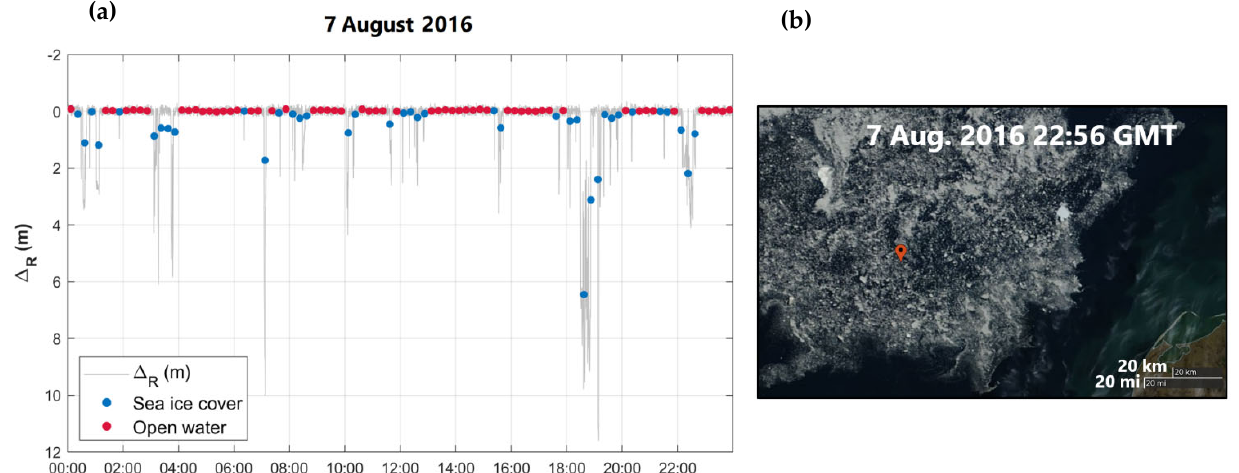
Figure 10. Plot of ∆ R with the SOM analysis for 7 August 2016 with accompanying mostly cloud-free true color Terra/MODIS satellite image. The full-resolution ∆ R time series (( a ); 20-s ping interval) from the AZFP in the NE Chukchi Sea is plotted in gray, with each 15-min period ∆ R mean marked as Mode 1 (open water; red) or Mode 2 (ice cover; blue) according to the SOM. The red marker’s point in the satellite image ( b ) shows the location of the CEO moorings.